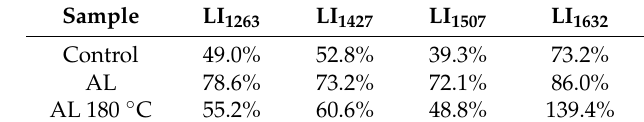
Table 2. Lignin index (LI) for the Control, AL, and AL 180 °C samples.